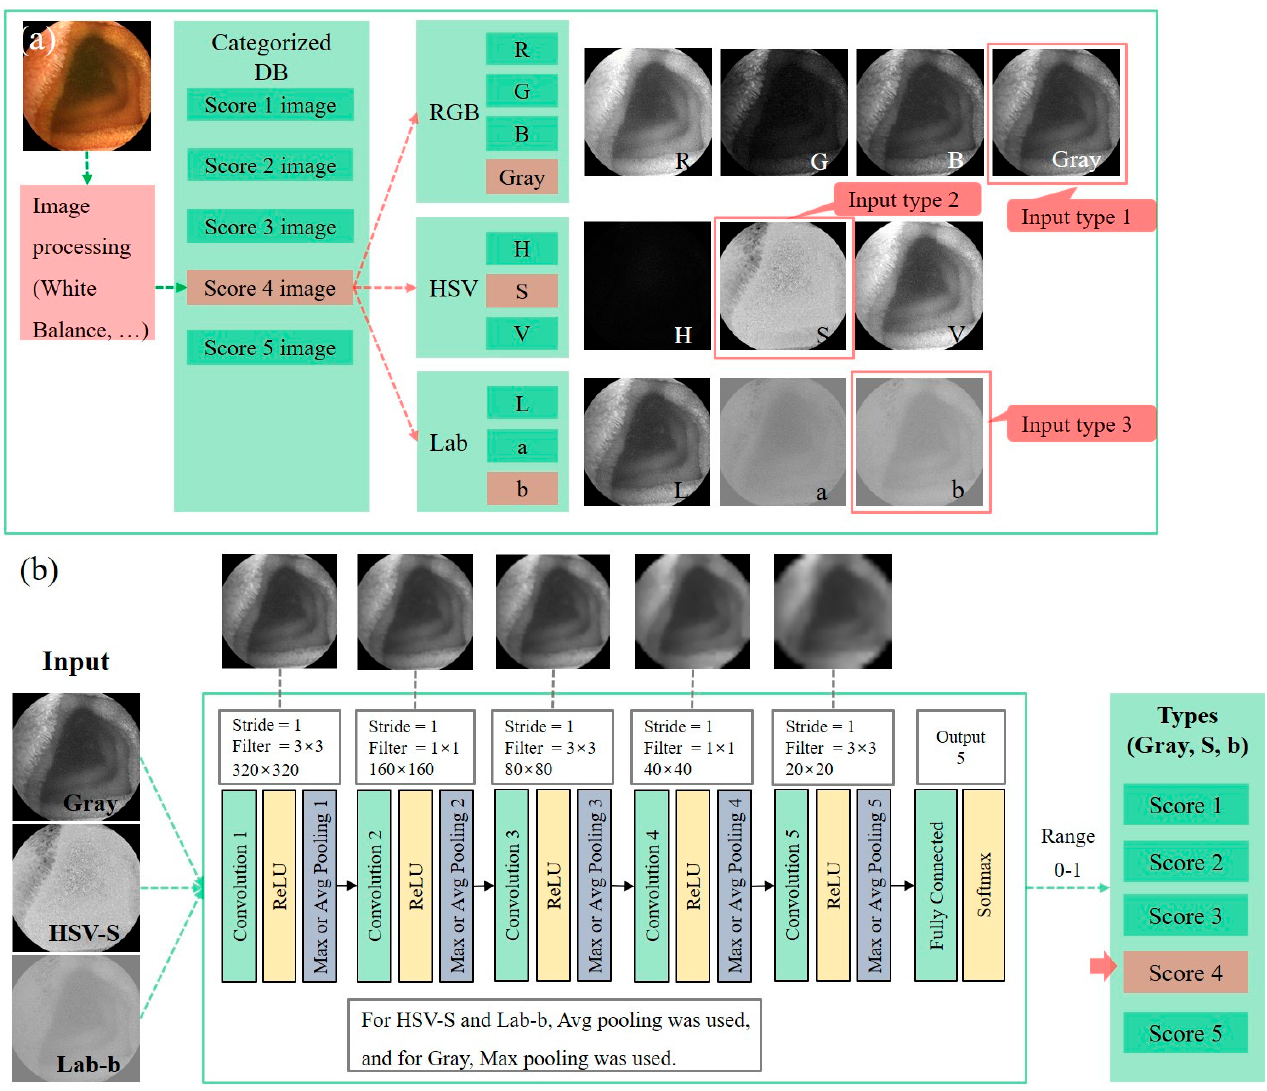
Figure 3. Deep learning process for algorithm development. ( a ) Pre-processing of input data, ( b ) repeat of training and testing. DB, database; HSV, hue saturation value; ReLU, rectified linear unit; RGB, red green blue.